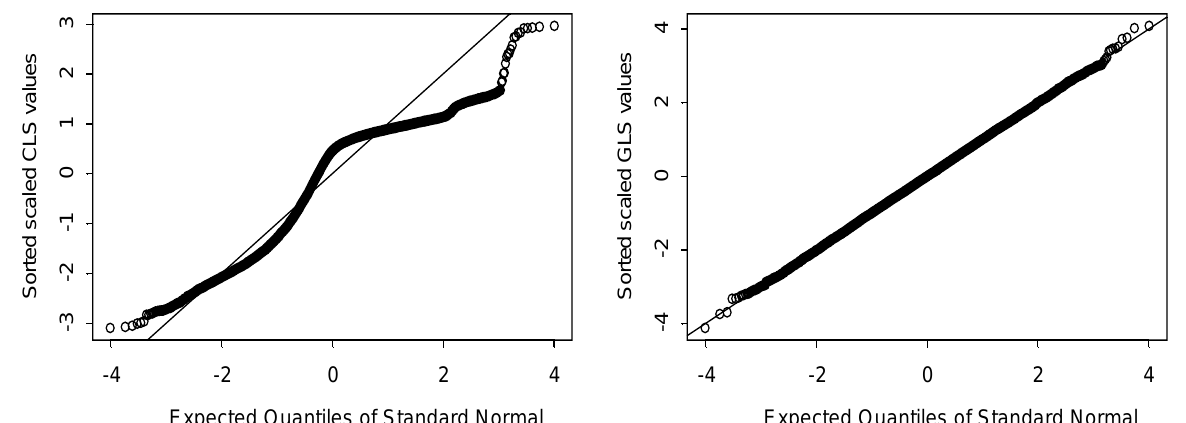
Figure 4 . Normal probability plots of F and GLS values in two different chemical directions (the top row is one direction; the bottom row is another direction) from 16,384 randomly selected pixels from scene